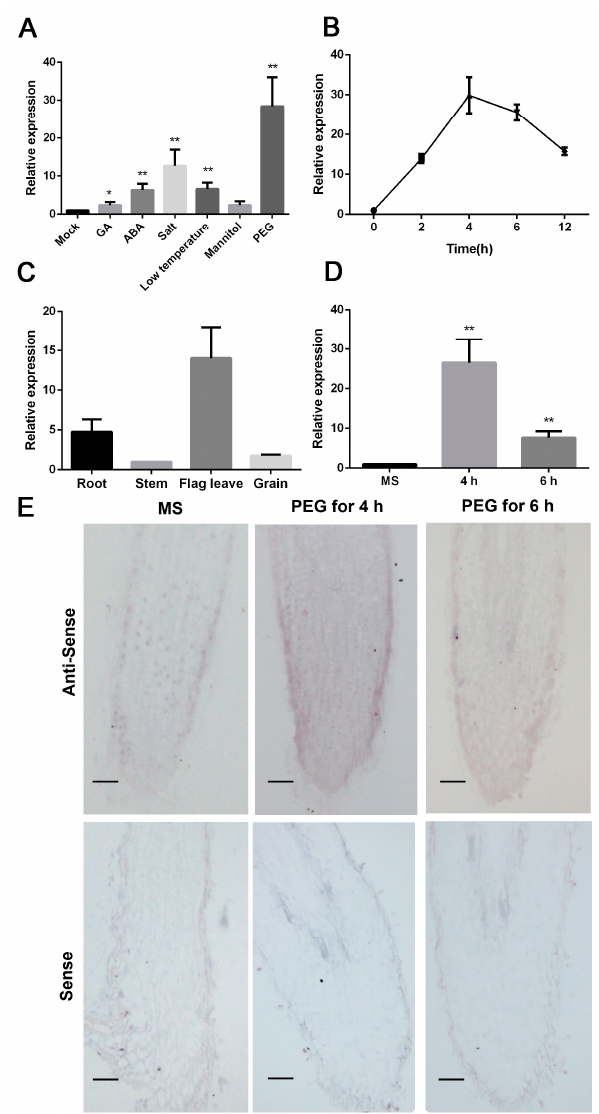
Figure 1. SbNAC9 responds to PEG ‐ simulated dehydration stress. ( A ) Relative expression of SbNAC9 in the fourth leaf of sorghum seedlings at four ‐ leaf stage under hormone and abiotic stress treatments. Sorghum seedlings were used for water (Mock), 150 μ M GA (gibberellin), 150 μ M ABA, 200 mM NaCl, 200 mM mannitol, and 20% PEG6000 treatments. For low temperature treatment, sorghum seedlings were kept at 4 °C. SbEIF4A was used as the internal reference. Error bars indicate SD of three independent experiments. ** p < 0.01 and * p < 0.05 by Student’s t ‐ test. ( B ) Time course transcript level of SbNAC9 in sorghum seedlings at four ‐ leaf stage subjected to 20% PEG treatment. SbEIF4A was used as the internal reference. Error bars indicate SD of three independent experi ‐ ments. ( C ) Relative transcript level of SbNAC9 in various tissues of sorghum at filling stage. SbEIF4A was used as the internal reference. Error bars indicate SD of three independent experiments. ( D ) Relative expression level of SbNAC9 in the three ‐ day ‐ old root tips of sorghum under MS media soaked into 20% PEG solution for 4 h and 6 h. SbEIF4A was used as the internal reference. Error bars indicate SD of three independent experiments. ** p < 0.01 by Student’s t ‐ test. ( E ) In situ hybridization assay of SbNAC9 in root tips of the three ‐ day ‐ old sorghum seedlings subjected to 20 % PEG ‐ simu ‐ lated drought ‐ stress treatment for 4 h and 6 h. Root tips grown on MS media served as negative control. Bars indicate 100 μ m.